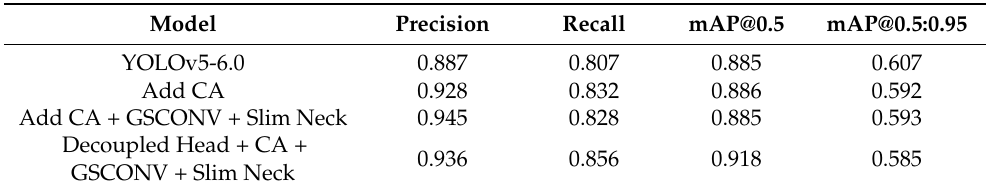
Table 6. Comparison between the improved model after adding Decoupled Head structure to Detect layer and the improved model